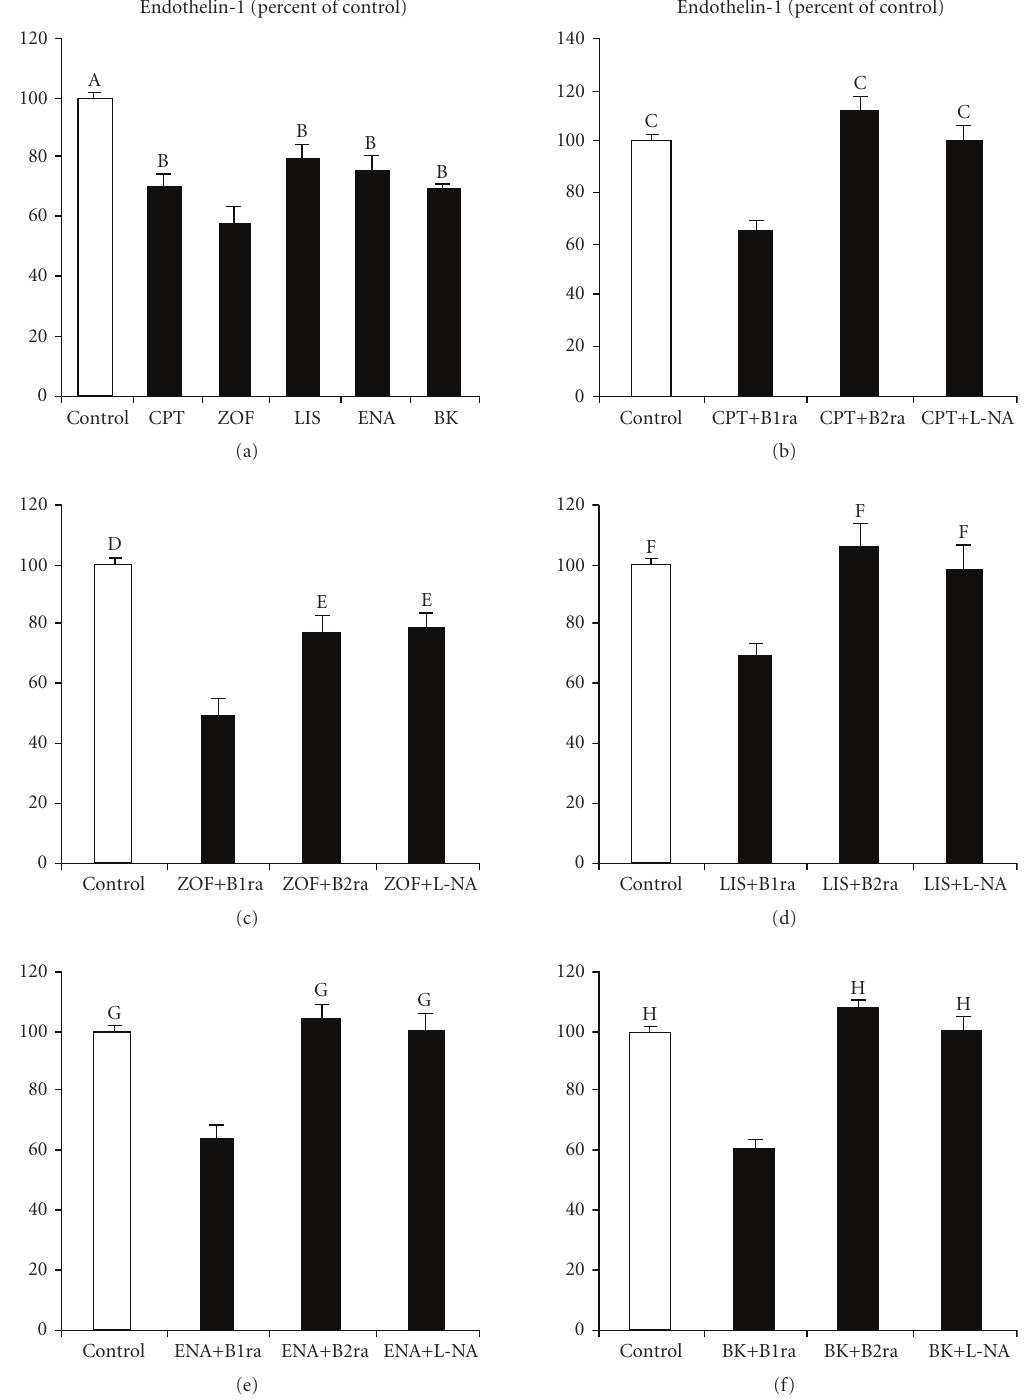
Figure 1: E ff ects of 10 − 8 M captopril (CPT, (a) and (b)), zofenoprilat (ZOF, (a) and (c)), lisinopril (LIS, (a) and (d)), enalaprilat (ENA, (a) and (e)) and bradykinin (BK, (a) and (f)) on endothelin-1 secretion (expressed as % of control) by vascular endothelial cells derived from umbilical cord vein after 8 hours of incubation both alone and in the presence of either Des-Arg 9 -[Leu 8 ]-BK, that is, a bradykinin B 1 receptor antagonist (B1ra, 10 − 6 M), or D-Arg-[Hyp 3 ,Thi 5,8 ,D-phe 7 ]-BK, that is, a bradykinin B 2 receptor antagonist (B2ra, 10 − 6 M), or the NO synthase competitive inhibitor N ω -nitro-L-arginine methyl ester (L-NA, 3 × 10 − 3 M). (A) P < . 0008 or less versus CPT, ZOF, LIS, ENA, and BK; (B) P < . 04 or less versus ZOF; (C) P < . 0005 or less versus CPT+B1ra; (D) P < . 0003 or less versus ZOF+B1ra, ZOF+B2ra, and ZOF+L-NA; (E) P < . 002 versus ZOF+B1ra; (F) P < . 0001 versus LIS+B1ra; (G) P < . 0002 or less versus ENA+B1ra; (H) P < . 0001 versus